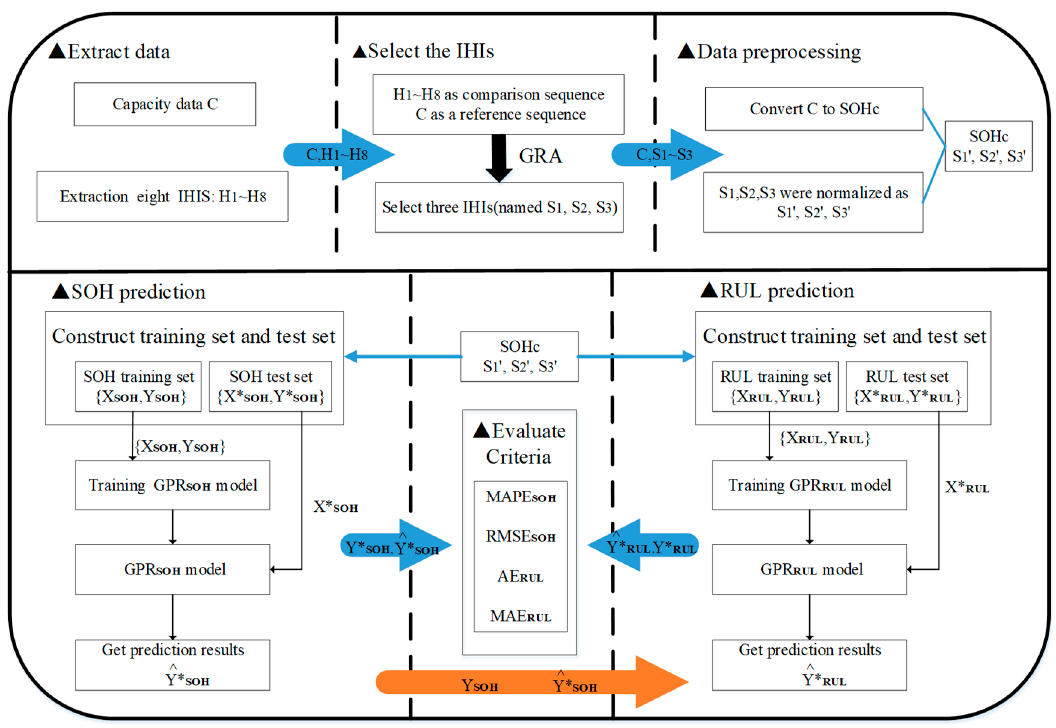
Figure 4. Schematic diagram of the proposed GPR method for prediction.